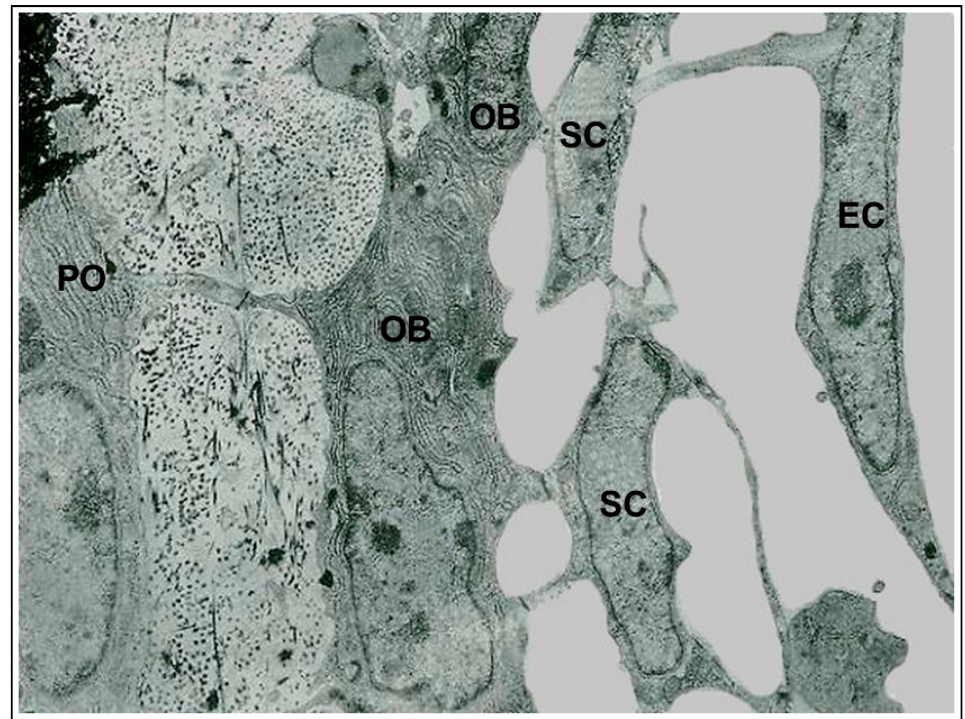
Figure 2. Transmission electron microscope (TEM) micrograph showing the continuous cytoplasmic network of the cells of the osteogenic lineage, extending from osteocytes to endothelial cells. (PO preosteocyte, OB osteoblast, SC stromal cell, EC endothelial cell). ×22,500.